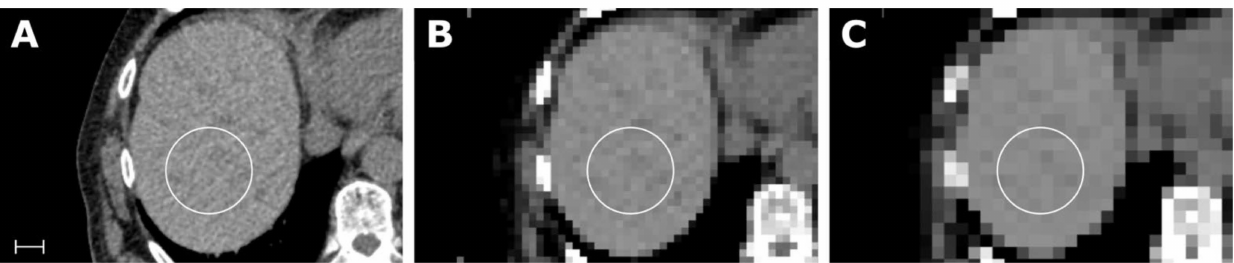
Figure 3. Samples of an abdominal CT ( A ) with corresponding maps for the feature Root Mean Squared (RMS), with a resolution of 5 × 5 × 5 mm in ( B ) and 10 × 10 × 10 px in ( C ). Scale indicates 2 cm. The value for RMS in the liver parenchyma from the conventional extraction and for both maps was 1060. Details of the scan and feature extraction as well as a full list of all values is available in electronic Table